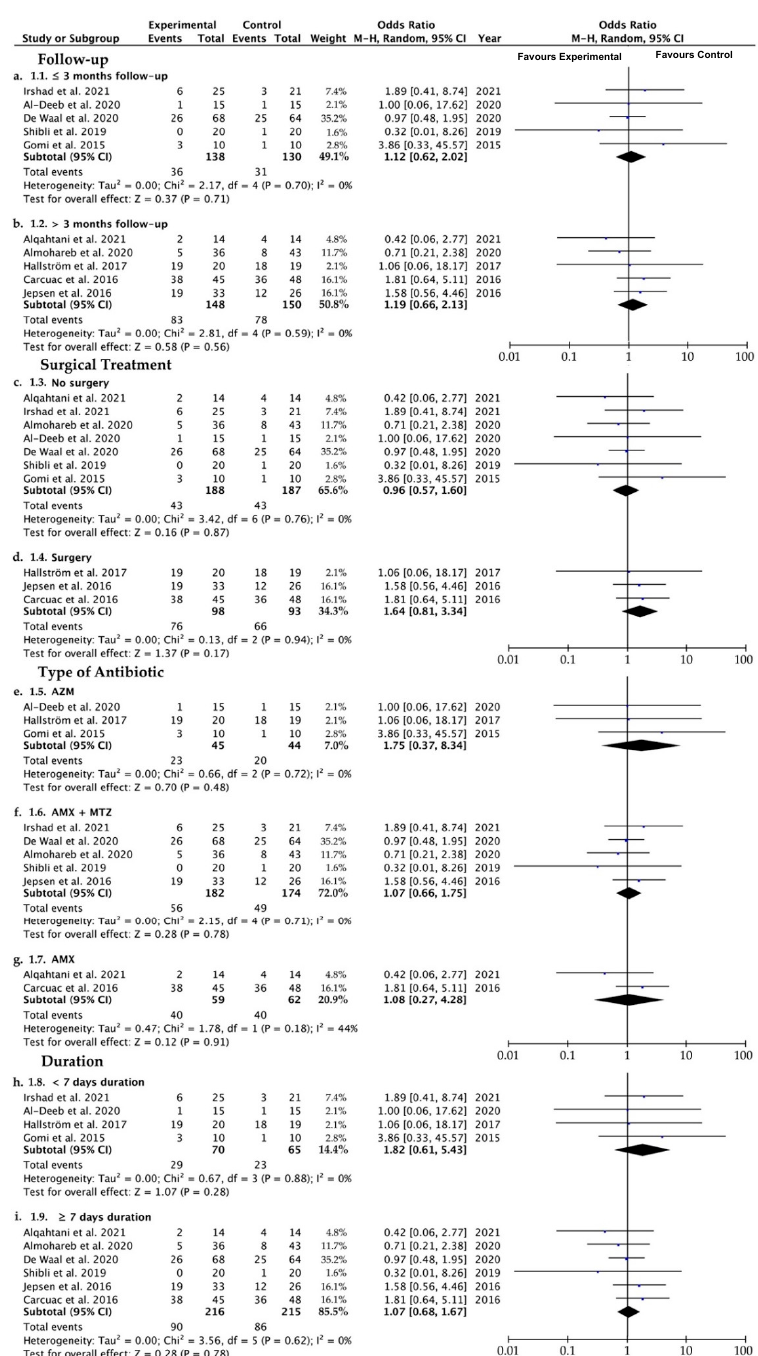
Figure 5. Forest plot for no systemic antibiotic (control group) versus adjunct systemic antibiotic (test group) when comparing the bleeding on probing (BoP) after ( a ) three months or less of follow- up, ( b ) more than 3 months of follow-up, ( c ) performing an implant exposure surgery or open flat debridement, ( d ) performing non-surgical subgingival debridement, ( e ) azithromycin as adjunct systemic antibiotic, ( f ) metronidazole plus amoxicillin as adjunct systemic antibiotic, ( g ) amoxicillin as adjunct systemic antibiotic, ( h ) less of 7 days of antibiotic administration, and ( i ) more than 7 days of antibiotic administration. Weighted mean is presented at CI 95%. Heterogeneity was determined using Higgins (I 2 ). In all the analyses, a random-effects model was applied. Statistical significance was set at 0.05